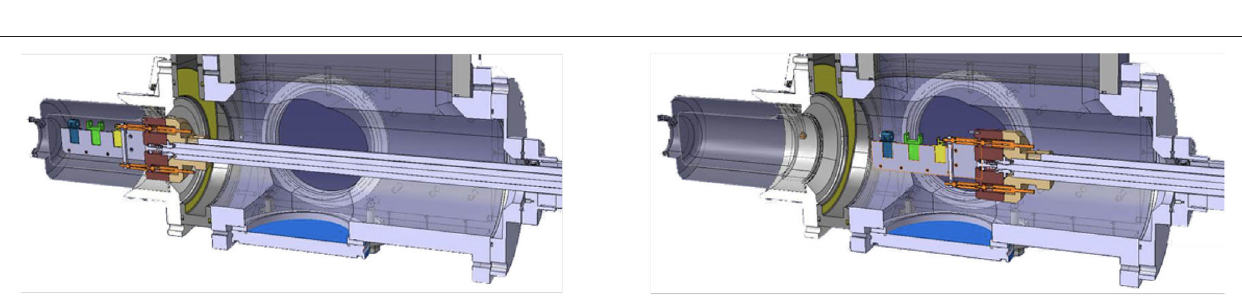
FIGURE 2 | Mass separator donated by KU Leuven to the MEDICIS experiment while at the LISOL facility (Left) and once installed at the MEDICIS bunker (Right) . The window that was installed to allow lasers to be sent toward the ion source for resonance ionization is clearly seen in the right-hand image.